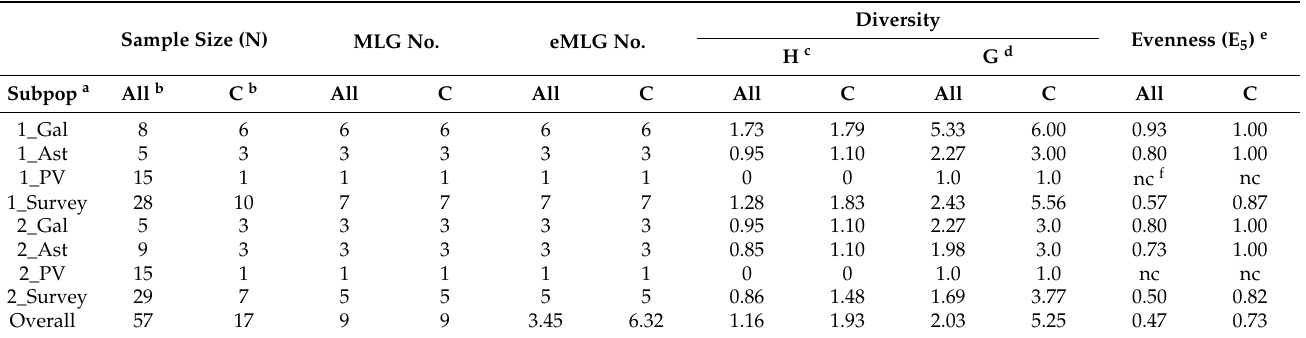
Table 2. Genotypic diversity for Spanish population of Fusarium circinatum within subpopulations defined in a temporal scale and by geographic origin.